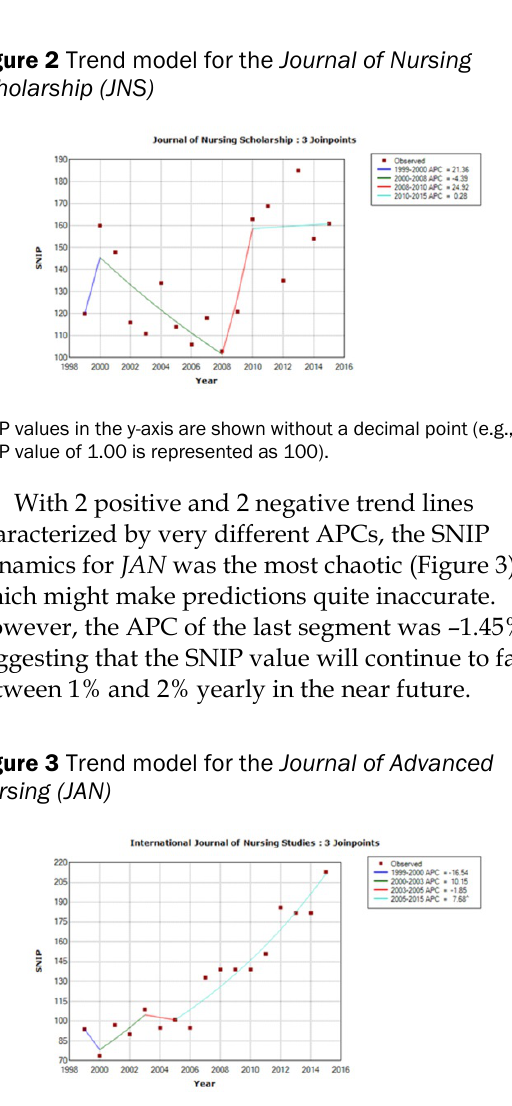
SNIP values in the y-axis are shown without a decimal point (e.g., a SNIP value of 1.00 is represented as